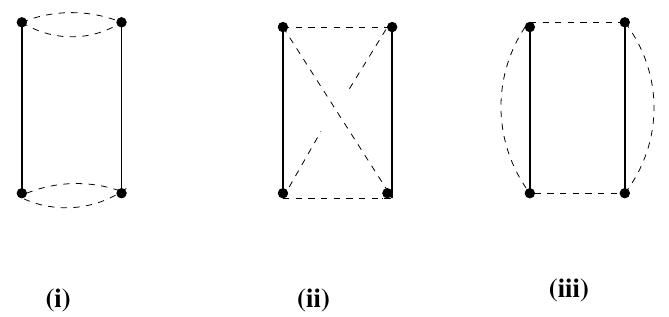
Figure 2 . The string invariants (i) B 2 , (ii) B 3 and (iii) B 4